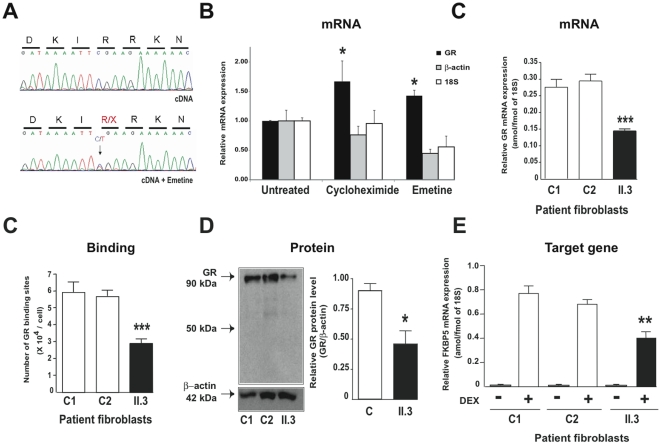
Evidence of GR haploinsufficiency in the proband's fibroblasts due to nonsense-mediated mRNA Decay.
A) Demonstration of GR haploinsufficiency in the fibroblasts of the propositus (II.3). Sequencing of exon 4 genomic DNA prepared from the patient's fibroblasts confirmed the presence of the heterozygous C>T substitution as observed in lymphocyte genomic DNA (see Supplemental Fig. S1A SI lower panel). In contrast, direct sequencing of the cDNA (see specific primers in Supplemental Table S1 SI) prepared from fibroblast RNA revealed only the wildtype C allele. The absence of mutated GR transcripts (upper panel) in the patient's fibroblasts is consistent with nonsense-mediated mRNA Decay, a cellular mechanism that prevents translation of mutated mRNA bearing a premature termination codon. When fibroblasts were treated for 6 h with 100 µg/ml emetine (lower panel) or for 2 h with 20 µg/ml cycloheximide (not shown), the expression of the defective allele was restored as shown by direct sequencing of the corresponding cDNA fragment. B) Increase in GR mRNA expression in fibroblasts of patient II.3 after exposure to two inhibitors of nonsense-mediated mRNA Decay, cycloheximide (20 µg/ml for 2 h) or emetine (100 µg/ml for 6 h). Relative expression of GR, beta-actin ou 18S RNA was measured by using quantitative real-time RT-PCR. Results are means ± SEM of 4 determinations and expressed as fold induction relative to untreated cells. (* P<0.05 Kruskal Wallis followed by Dunn's post test and Mann Whitney test). C) Reduction of GR mRNA expression in fibroblasts of patient II.3 compared with two controls C1 and C2. The expression of mRNA was measured by using quantitative real-time RT-PCR. Results are expressed as attomol/fmol of 18S and are means ± SEM of 3 independent determinations (*** P<0.001 Mann Whitney test). D) Reduction in specific [3H]-DXM binding sites. Fibroblasts pre-incubated in steroid-free medium for 24 h, were exposed to 50 nM [3H]-DXM in the absence or presence of a 500-fold excess of unlabeled DEX for 1 h at 37°C. Radioactivity was measured and specific binding was calculated. Data are means ± SEM of 3 independent determinations performed in triplicate. The estimated GR density in the propositus' fibroblasts was 3×104 sites per cell (*** P<0.001 vs controls). E) Western blot analysis of GR. Thirty micrograms of protein from fibroblast homogenates of controls (C1 and C2) and patient II.3 were processed for immunoblotting with anti-GR (upper panel) and anti-b actin (lower panel). Note the presence of a specific 90-kDa GR in controls and an approximately 50% reduction in WT GR expression in patient II.3 whereas the 50-kDa band corresponding to the truncated hGRa-R469X mutant was not detected. Quantitative analysis of GR signals normalized to b-actin loading was performed using QuantityOne software (Biorad). Results are means ± SD of at least 3 independent analyses (* P<0.05 Mann Whitney test). F) Altered glucocorticoid-inducible gene expression in the patient's fibroblasts. Fibroblasts from controls (C1 and C2) and from patient II.3 were starved for 24 h in steroid-free medium and then exposed to 100 nM DXM for 6 h. Relative levels of FKBP5 transcripts were determined by quantitative real-time RT-PCR analysis. Results are expressed as attomol/fmol 18S and are means ± SEM of 6 independent determinations (** P<0.01, Kruskal Wallis followed by Dunn's post test).